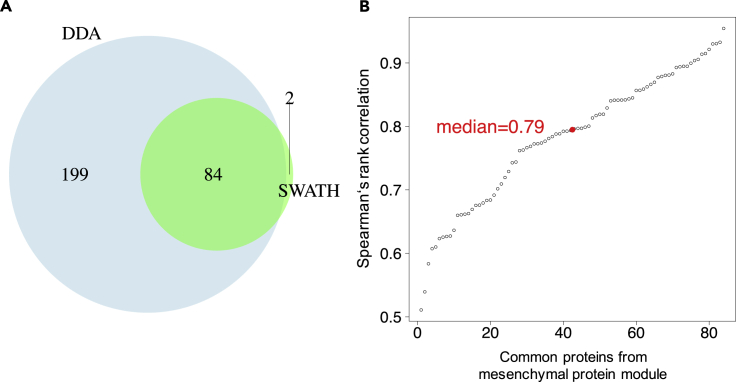
Comparison of Proteins Comprising the Mesenchymal Subtype Tumors in the iTRAQ DDA and SWATH-MS Data(A) High overlap of proteins characterizing the Mesenchymal subtype in the SWATH MS data and the iTRAQ DDA data.(B) Strong positive correlation of 84 proteins commonly comprising the Mesenchymal subtype in the iTRAQ DDA and SWATH-MS data (median ρ = 0.79).